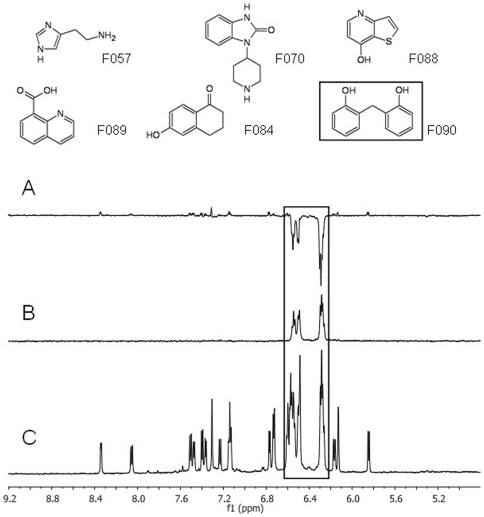
Identification of fragment molecule F090 as a ligand of PRDX5 from the NMR experiments.The Waterlogsy (A), STD (B) and normal 1H 1D (C) spectra (aromatic and ethylenic region) of a mixture of 6 fragments at a 600 µM concentration in presence of 20 μM PRDX5 are displayed. Only signals of the molecule F090 are observed in the STD experiment whereas the corresponding signals are in antiphase as compared to all other molecule signals in the Waterlogsy spectrum (framed regions).